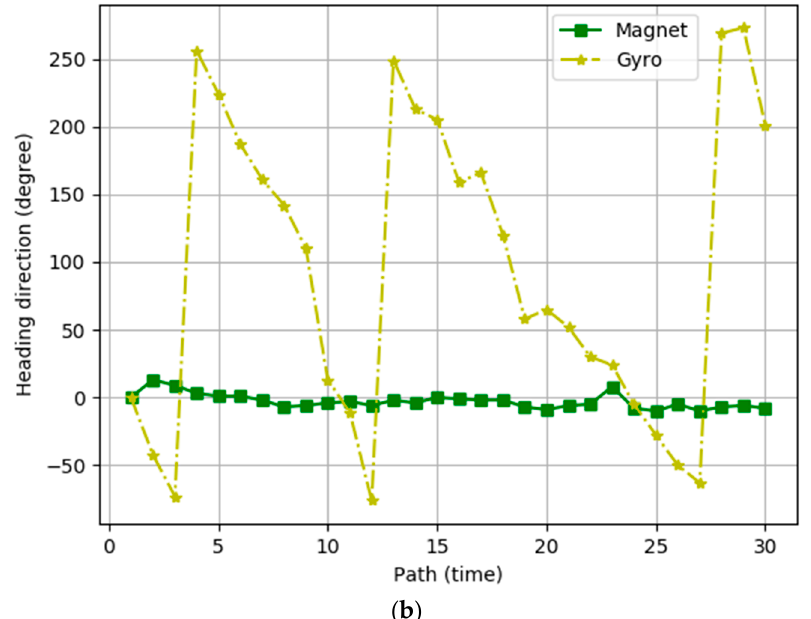
Figure 4. Heading directions measured at ( a ) the point A and ( b ) the point B in Figure 3.